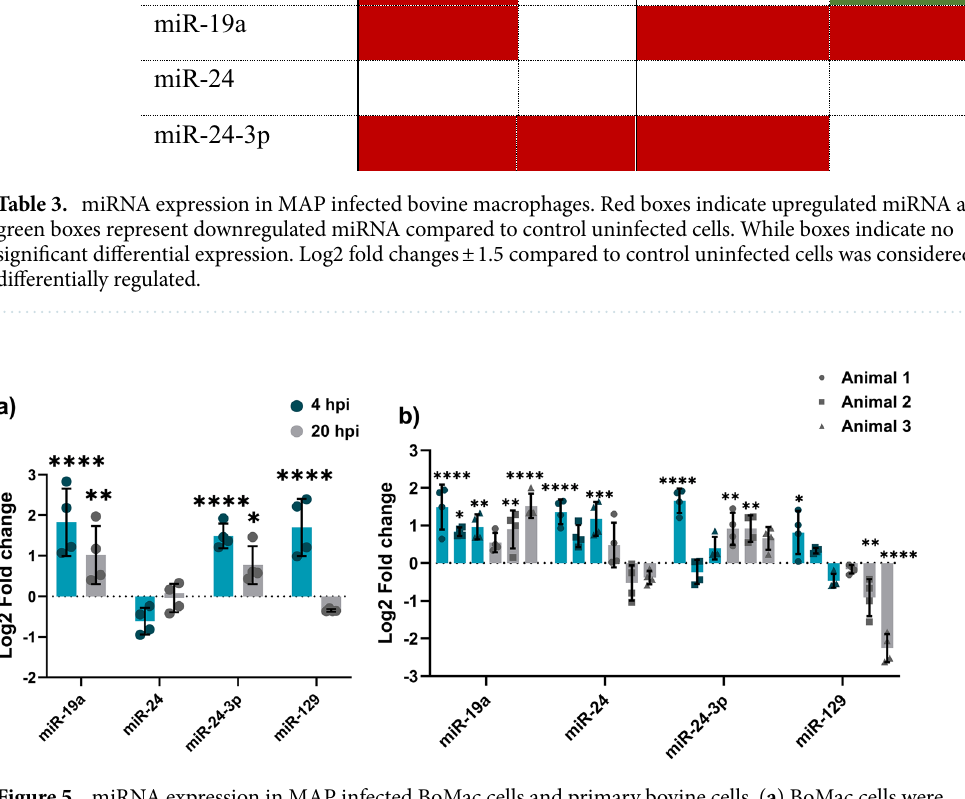
Figure 5. miRNA expression in MAP infected BoMac cells and primary bovine cells. ( a ) BoMac cells were infected with MAP and miRNA expression levels analysed by qPCR. ( b ) Primary bovine cells were cultured from PBMCs isolated from whole blood, infected with MAP, and miRNA expression analysed by qPCR. Columns represent the mean and error bars indicate the standard deviation. Asterisks indicate significantly different fold changes compared to control uninfected cells (*p ≤ 0.05, **p ≤ 0.01, ***p ≤ 0.001, ****p ≤ 0.0001). Graph is representative of 2 biological replicates for MAP infected cells and a single control uninfected sample, and 2 technical replicates of each